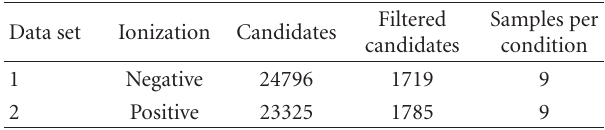
Table 1: Overview on data sets from the metabolomic case study for plant wounding experiments. The columns “Candidates” and “Filtered candidates” contain the number of marker candidates in the raw data set and the number of significant candidates in the filtered data set, respectively.